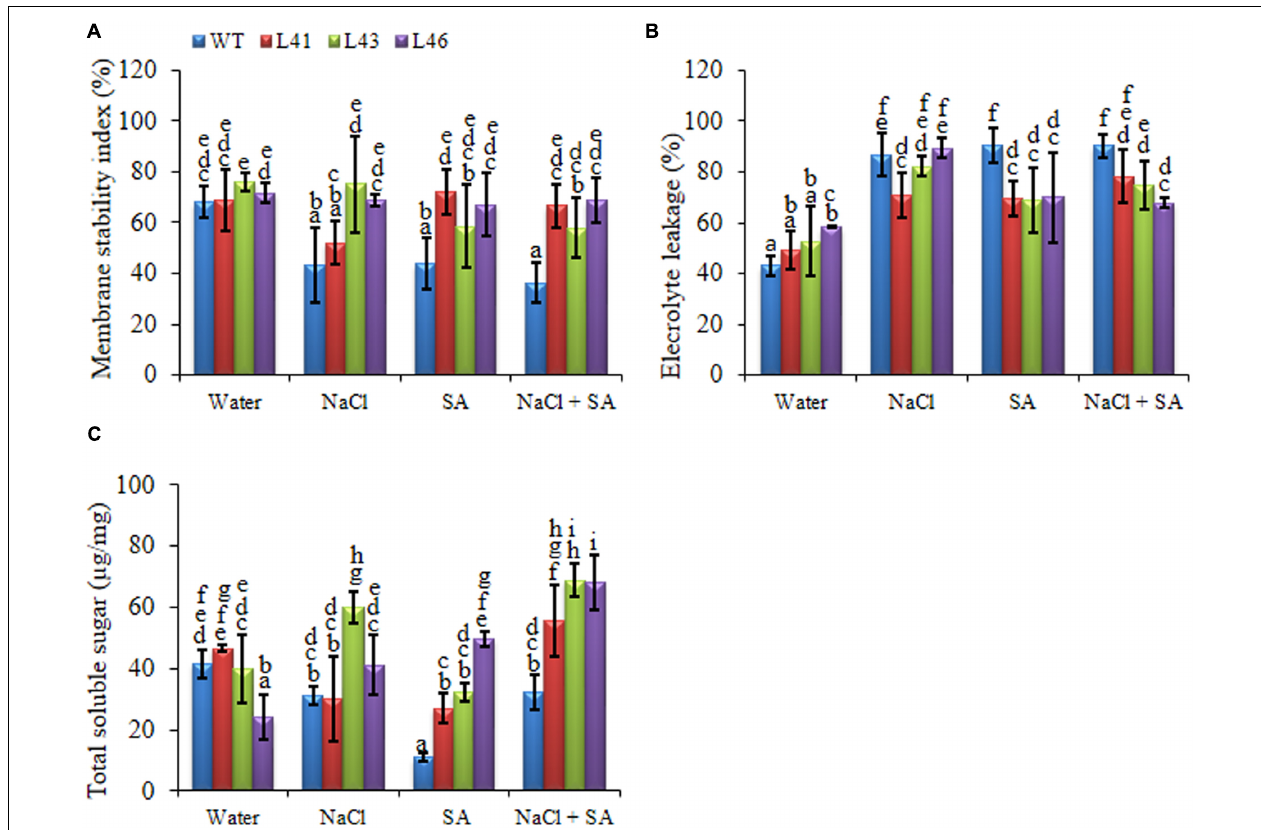
FIGURE 4 | Biochemical changes in WT and JcWRKY transgenic plants grown in the presence of 0, 200 mM NaCl, 150 µ M SA, and combined NaCl + SA stress. (A) Membrane stability index, (B) Electrolyte leakage and (C) Total soluble sugar content. Values are represented as mean ± SD ( n = 3) and marked with different alphabets to indicate significant difference at P ≤ 0.05